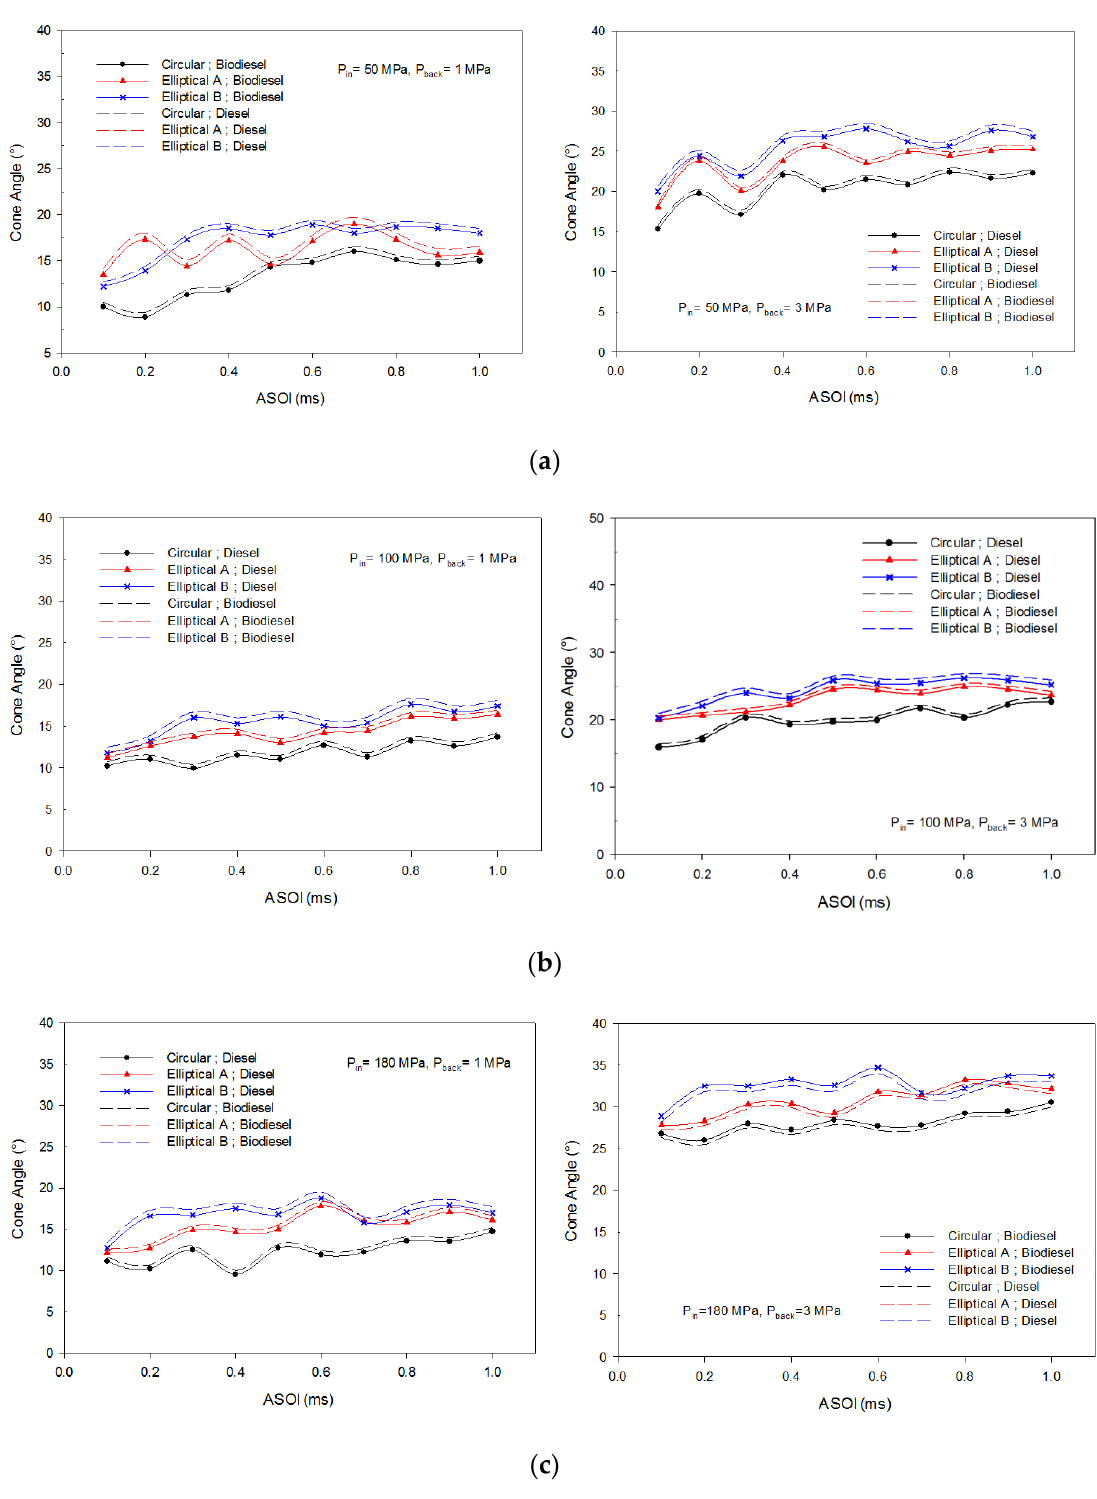
Figure 16. Spray cone angle for different types of nozzle shape and fuel: ( a ) 50 MPa pressure injection, ( b ) 100 MPa pressure injection, and ( c ) 180 MPa pressure injection. ( b ) 100 MPa pressure injection, and ( c ) 180 MPa pressure